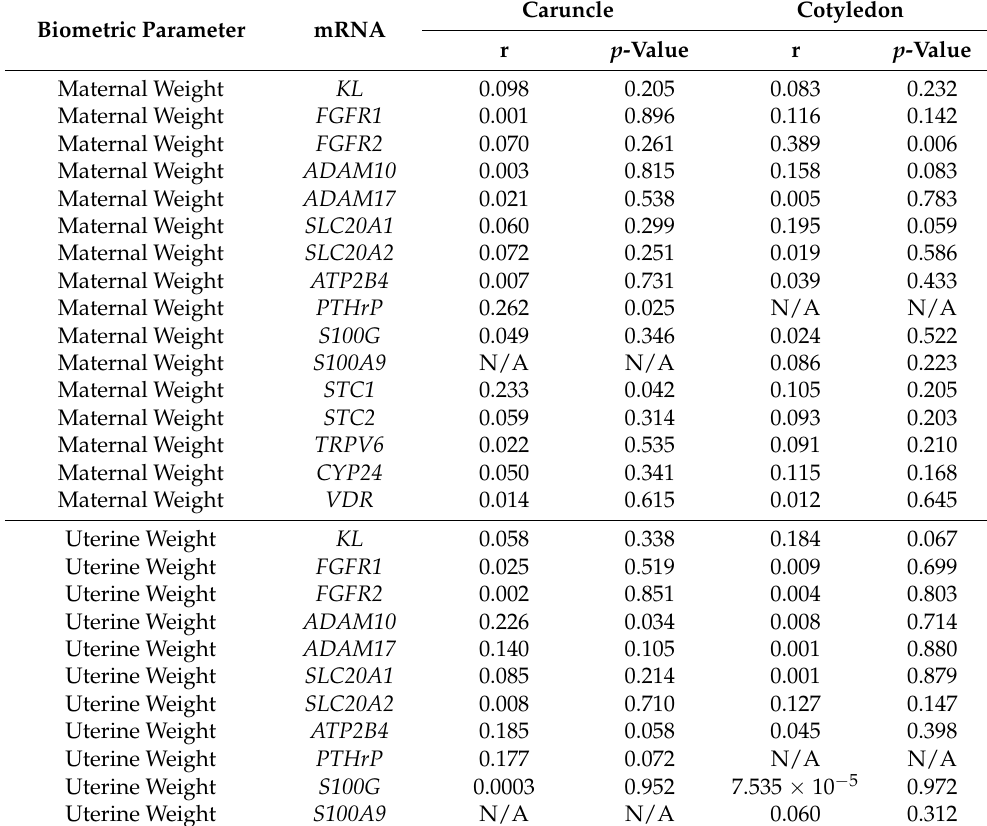
Table 3. Correlations between biometric data and the caruncular and cotyledonary mRNA expression of calcium, phosphate, and vitamin D regulatory molecules. Biometric